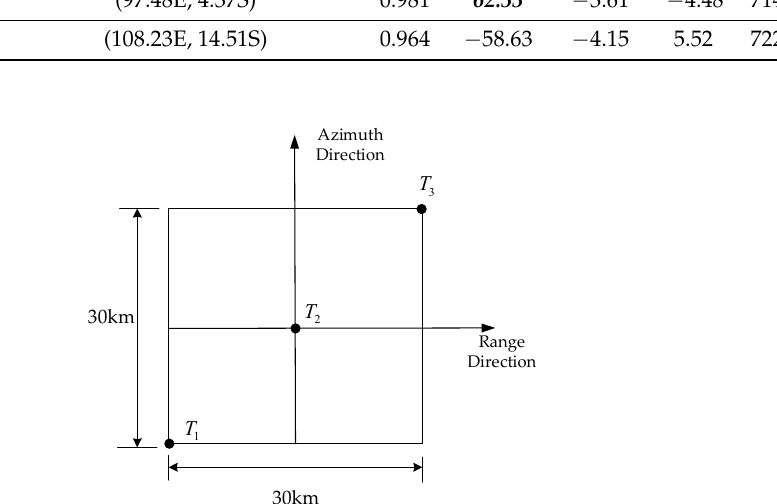
Table 2. Characteristics of candidate positions.